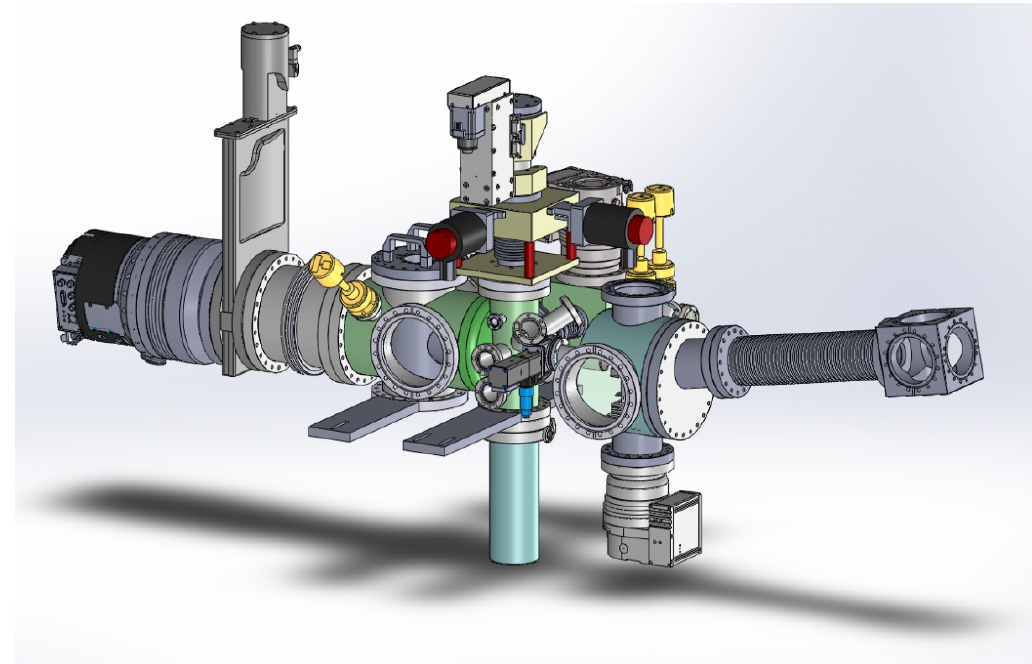
Figure 1: Schematic view of the LiXEdrom